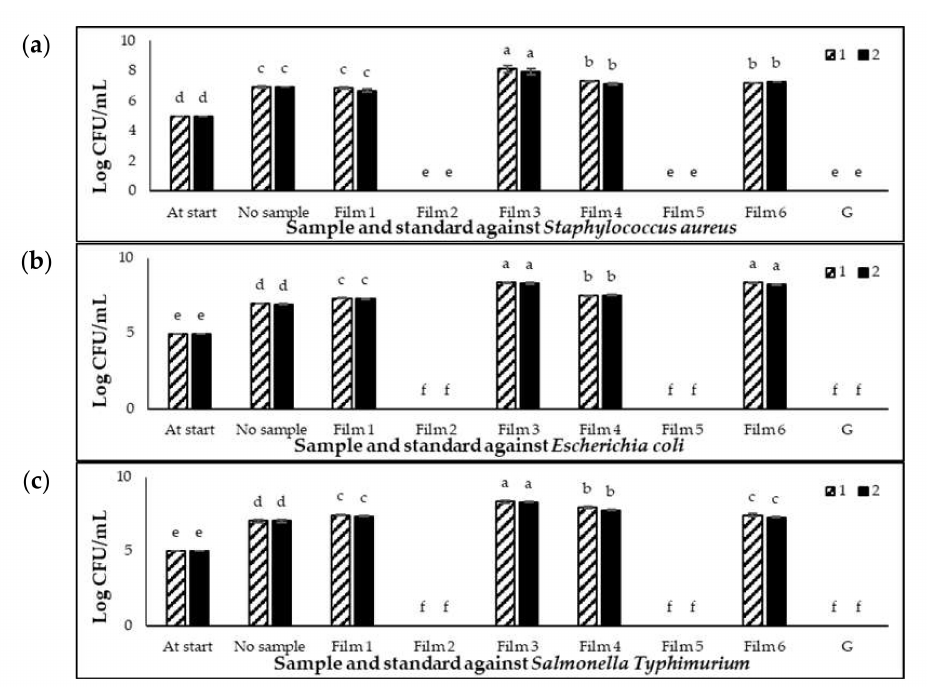
Figure 1. ( a ) Growth of Staphylococcus aureus , ( b ) growth of Escherichia coli, and ( c ) growth of Salmonella Typhimurium on films. At the start: 5 log CFU/mL of the culture cell number before incubation. 1: Location 1, 2: Location 2, No sample: no film, and G: Gentamicin. Error bars indicate the standard deviation ( n = 3). Small letters of a–f are different significantly ( p < 0.05) amongst the